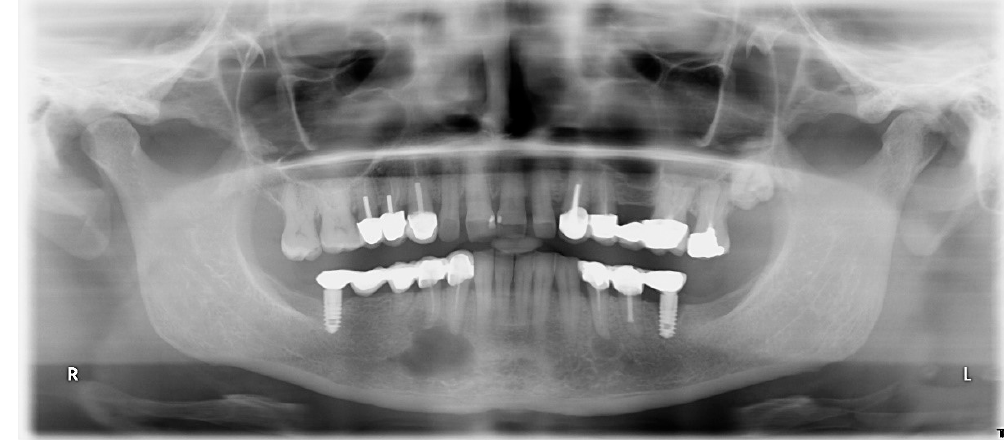
Figure 1. Rx Opt from 2010, taken when treating the patient.